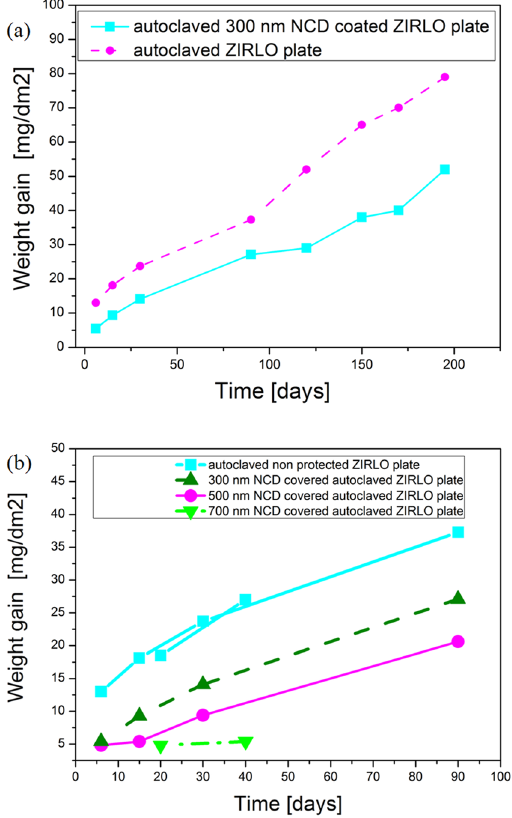
Figure 1. ( a ) weight gains (mg/dm − 2 ) measured after 6, 15, 30, 90, 120, 150, 170 and 195 days of exposure to hot water (360 °C) for uncoated and 300 nm NCD-coated ZIRLO plate samples. ( b ) weight gains (mg/dm − 2 ) measured after 6, 15, 20, 30, 40 and 90 days of exposure to hot water (360 °C) for uncoated, 300 nm NCD- coated, 500 nm NCD-coated and 700 nm NCD-coated ZIRLO plate samples. Thicker NCD layers provide ZIRLO plates with stronger protection against oxidation than thinner layers